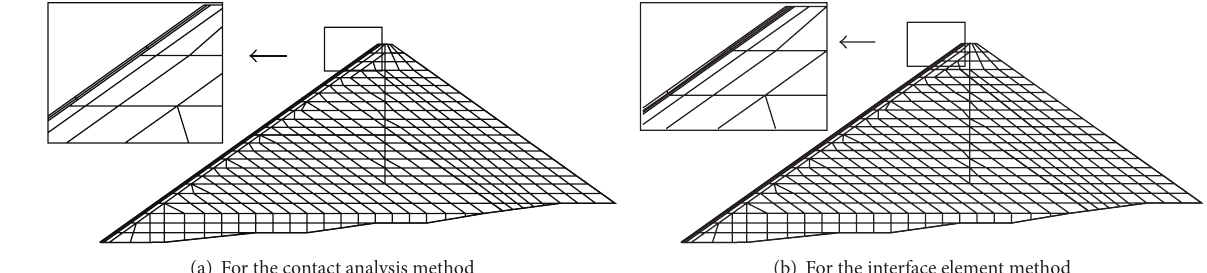
Figure 6: Two-dimensional finite element mesh.